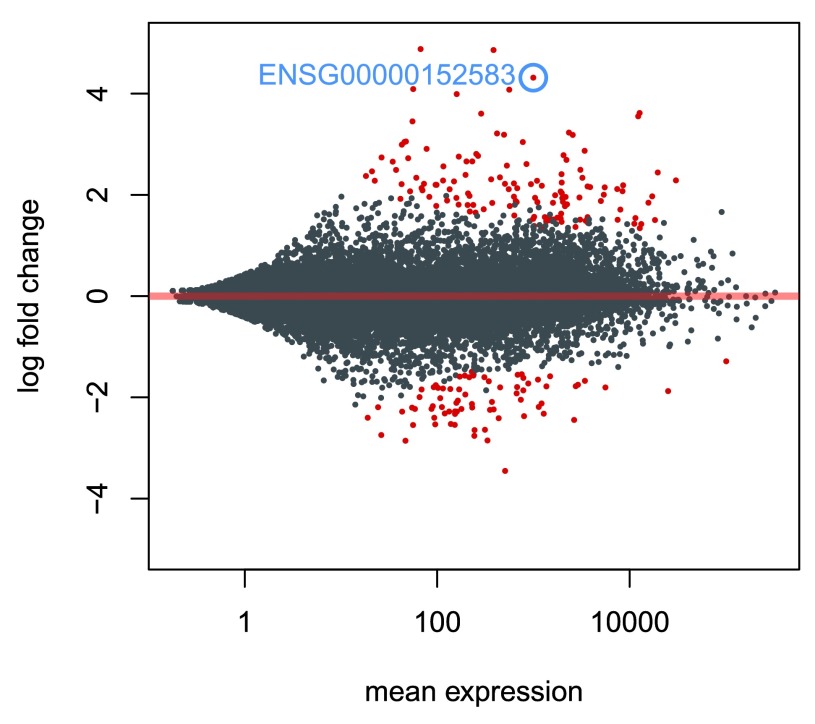
An MA-plot of a test for large log2 fold changes.The red points indicate genes for which the log2 fold change was significantly higher than 1 or less than -1 (treatment resulting in more than doubling or less than halving of the normalized counts) with adjusted
p value less than 0.1. The point circled in blue indicates the gene with the lowest adjusted
p value.